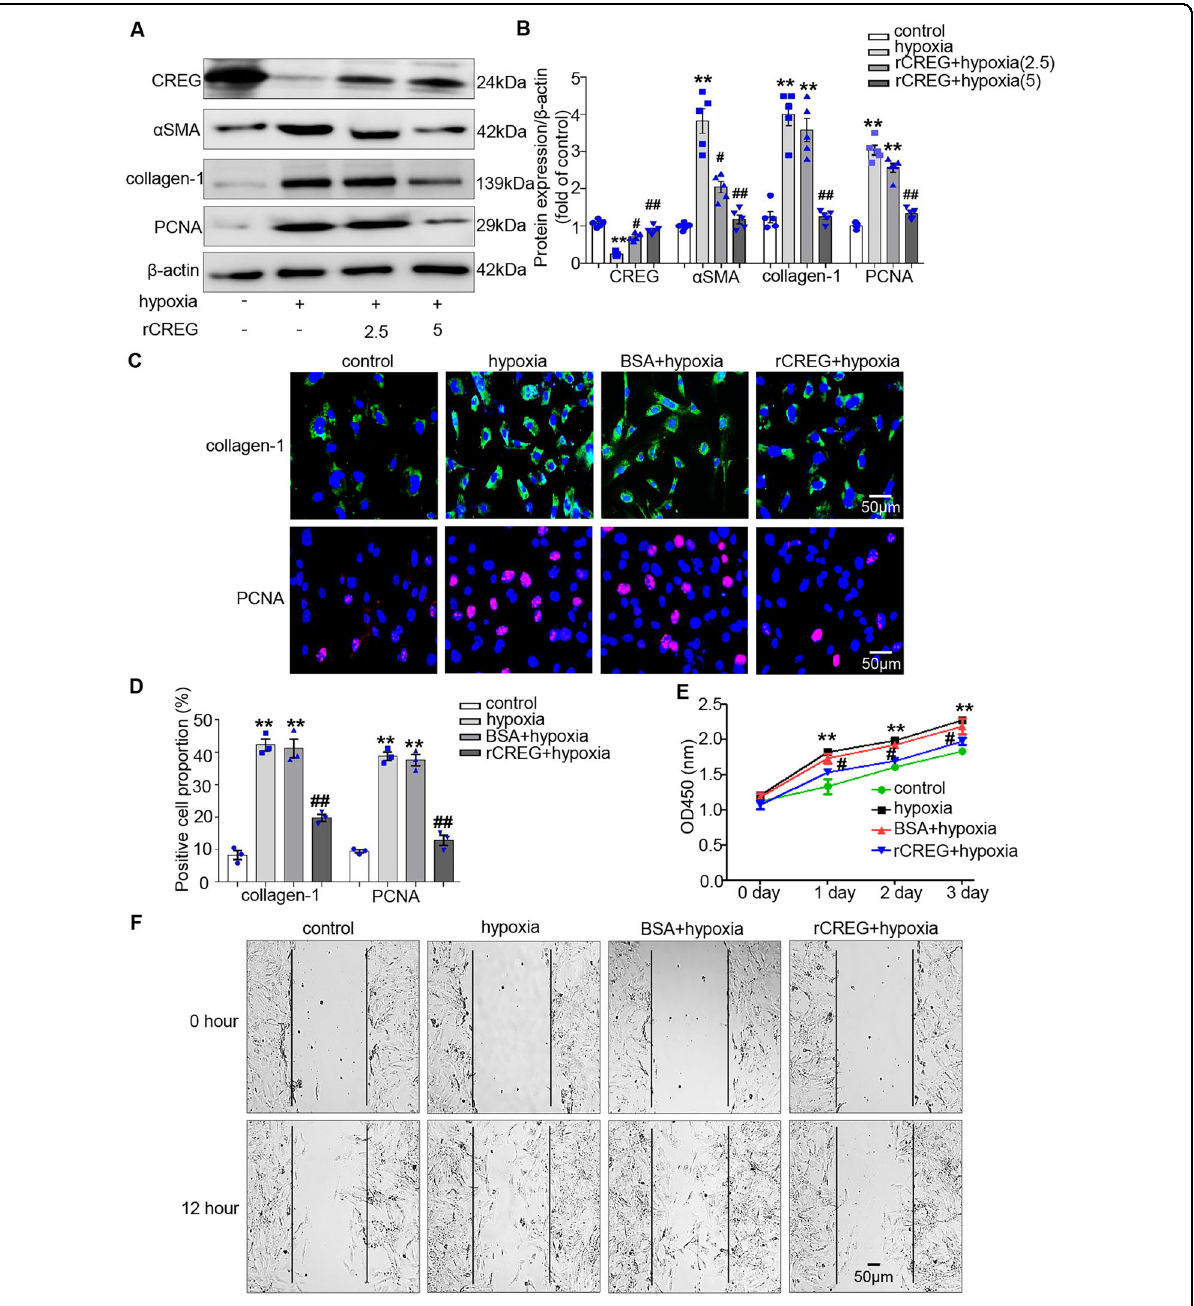
Fig. 6 CREG protein inhibited the phenotypic switching of cardiac fi broblasts in vitro. A , B The effects of CREG recombinant protein (rCREG) on the expression of α SMA and collagen-1 induced by hypoxia as determined by western blotting ( N = 5 per group). C , D The effects of rCREG on the expression of collagen-1 and PCNA induced by hypoxia as determined by immuno fl uorescence staining ( N = 3 per group). Green indicated collagen- 1 expression, red indicated PCNA expression, and blue indicated nuclei. E The effects of rCREG on cell proliferation were determined by CCK8 assays ( N = 5 per group). F The effects of rCREG on cell migration was determined by wound healing assays ( N = 3 per group). ** P < 0.01 vs. control group; ## P < 0.01, # P < 0.05 vs. BSA + hypoxia